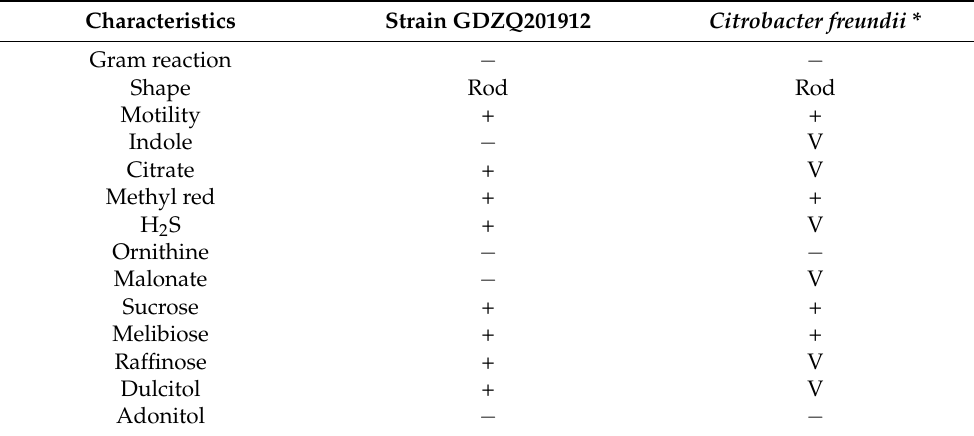
Table 3. Morphological properties and conventional tests of strain GDZQ201912 isolated from Macrobrachium rosenbergii